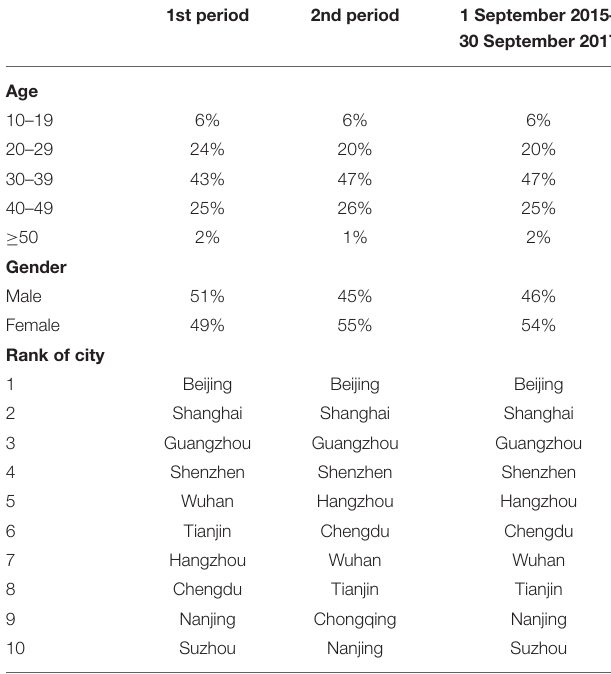
TABLE 1 | Baidu depression-related searchers–demographic and